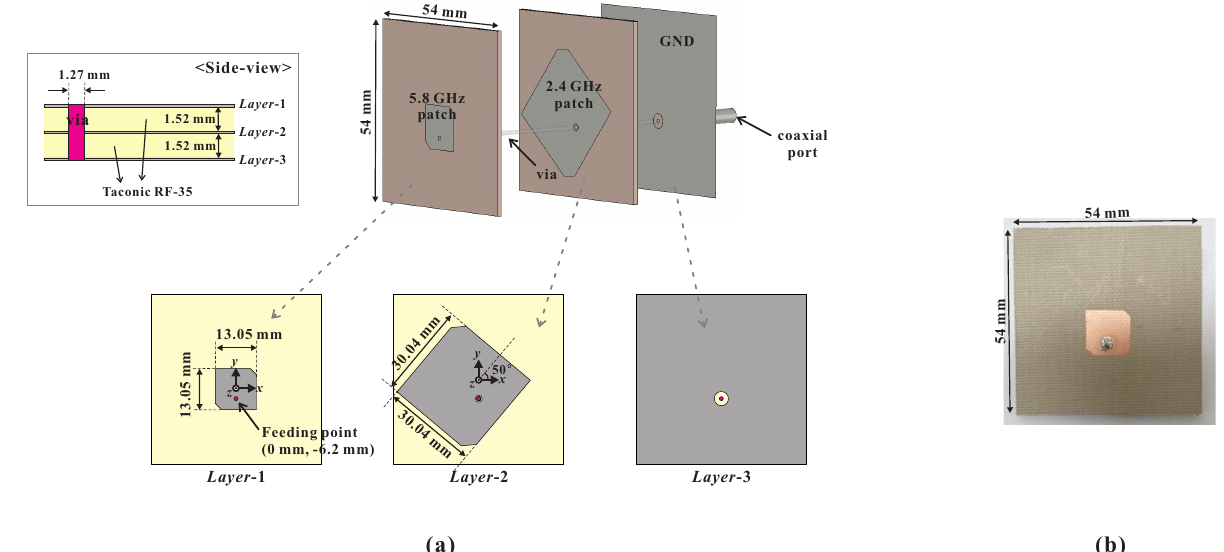
Figure 12. Dual-band (2.4 and 5.8 GHz) stacked patch antenna: ( a ) configuration; ( b ) top view of the fabricated antenna.